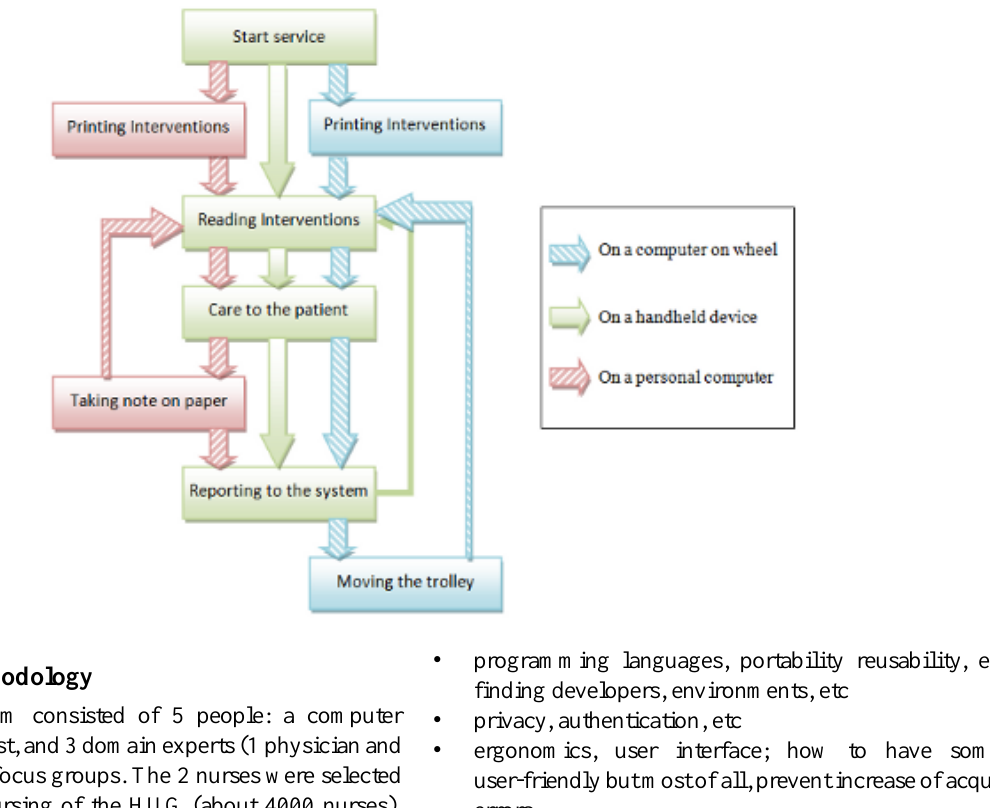
Figure 1. HUG nurses’workflow according to different